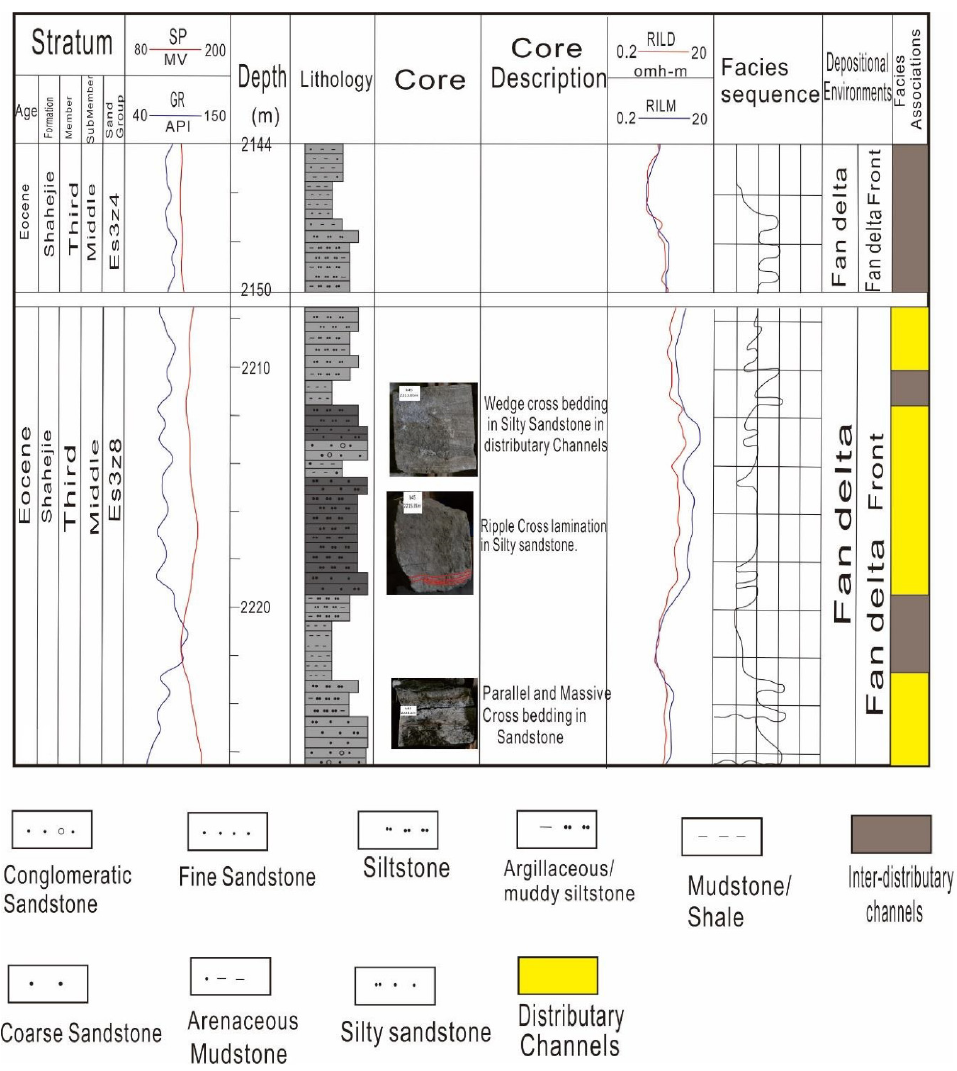
Figure 9. Core wells K45 in the study area with complete set of logs along facies, in which Wedge cross bedding in Light Gray silty sandstone is observed at 2213.85 m; Ripple cross lamination in silty sandstone at 2215.35 m and parallel as well as cross bedding in massive sandstone at depth of 2223.1 m.